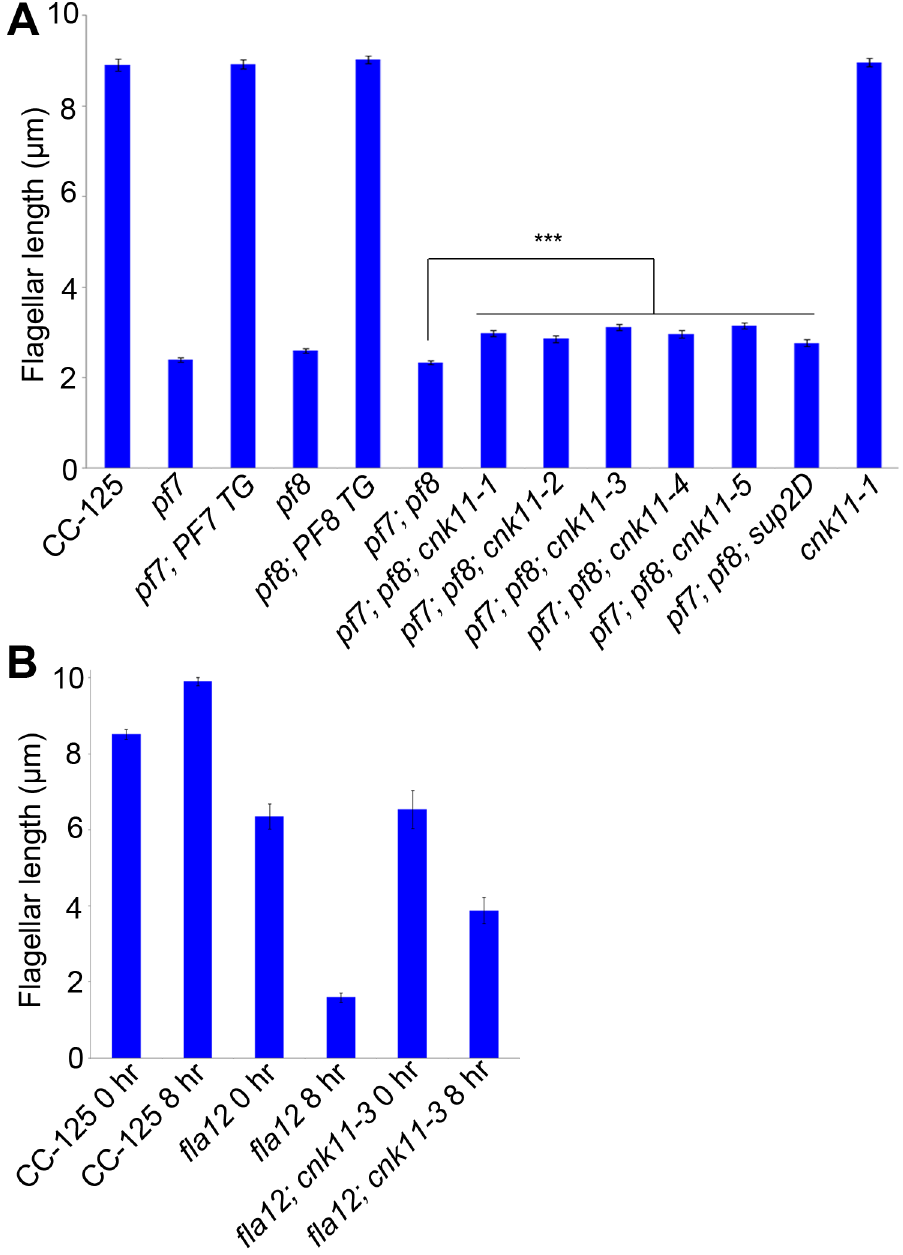
Fig 1. Flagellar length of ccdc39/ccdc40 mutants can be partially rescued by the cnk11 suppressors. At least 100 flagella from each strain were measured to determine the average flagellar length. Error bars represent standard deviation of the mean. (A) Flagellar length of various strains at 21°C. TG, transgene. *** indicates p < 0.001 by t-test. (B) Flagellar length of various strains before (0 hr) and after (8 hr) temperature shift to